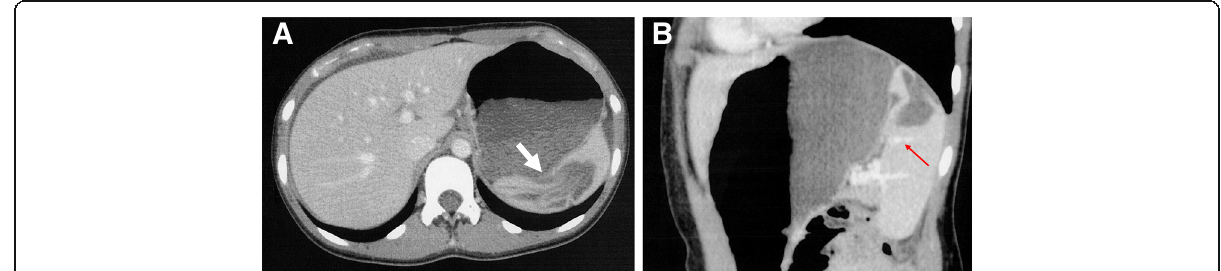
Fig. 1 a Transverse contrast-enhanced CT images demonstrated a large, collapsed splenic cyst communicating with the peritoneal cavity through the ruptured cyst wall (white arrow), and no neoplastic nodules nor abnormal calcifications were detected. b Sagittal contrast-enhanced CT images demonstrated a ruptured cyst with a branch of splenic vessels in the splenic parenchyma near the border of the collapsed cyst at the upper pole of the spleen (red arrow)